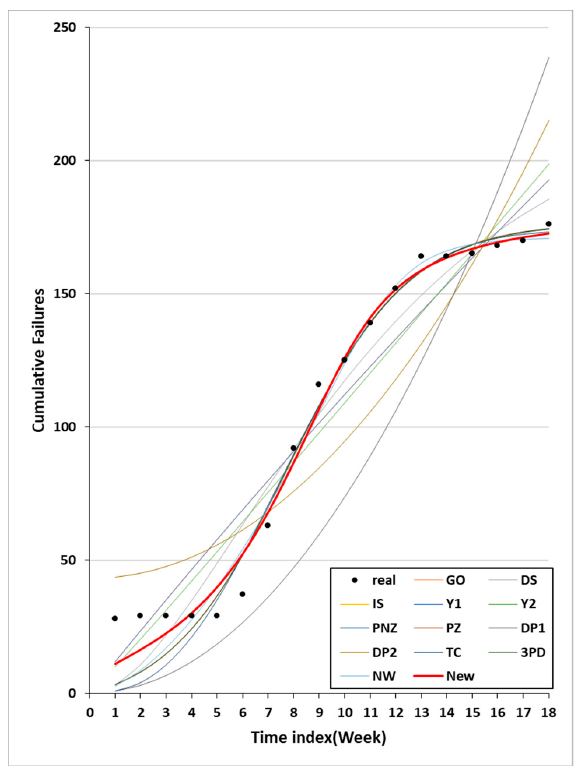
Figure 2. Actual data and estimated mean value function for Dataset #1.